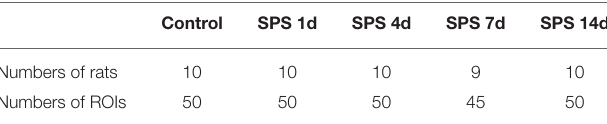
TABLE 1 | Numbers of rats examined by MRI and the numbers of sampled